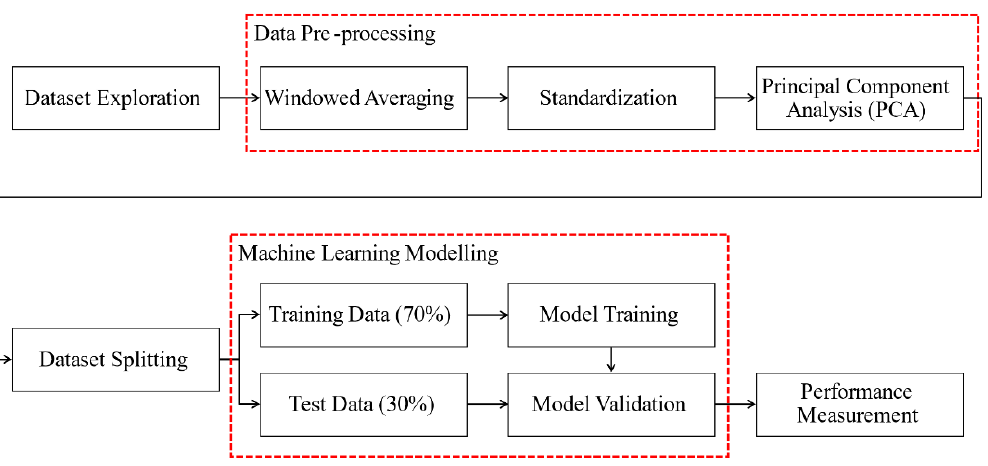
Figure 10. Experiment